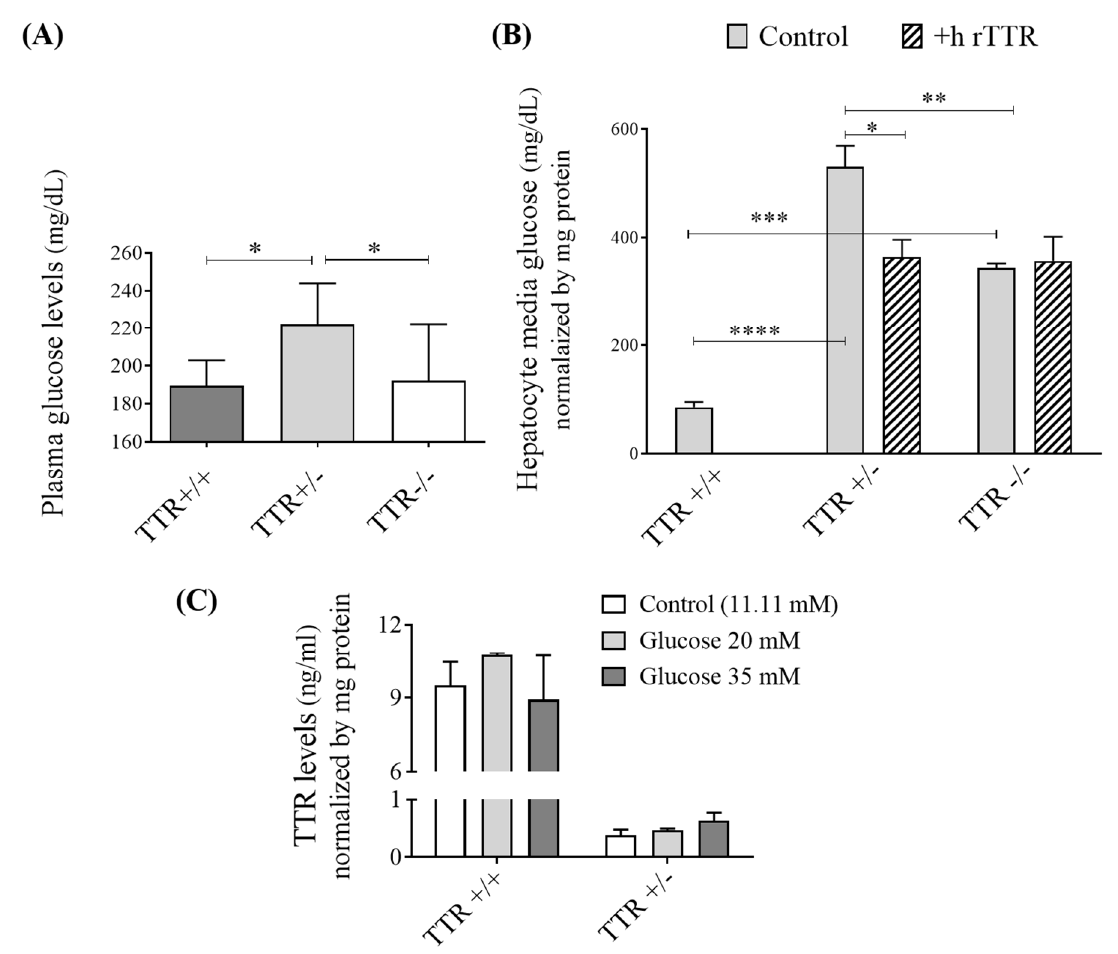
Figure 1. Effect of TTR and glucose on each other. ( A ) In mice, plasma glucose levels were shown to be higher in TTR+/ − mice ( N = 11), while TTR − / − ( N = 7) showed no alteration as compared to plasmas from TTR+/+ animals ( N = 5). ( B ) In primary hepatocytes, glucose levels, normalized by mg protein, were also higher in the extracellular culture media of primary hepatocytes derived from TTR+/ − and TTR − / − mice. Further addition of h rTTR to the media of TTR+/ − hepatocytes resulted in decreased glucose levels, while it did not alter glucose concentration in hepatocytes from TTR − / − mice. ( C ) In primary hepatocytes, different concentrations of glucose did not produce any alteration in the concentration of secreted TTR (N = 3 for each condition). Data are expressed as mean ± SD. Significant results are indicated by * when p < 0.05, ** when p < 0.01, *** when p < 0.001 and **** when p < 0.0001.